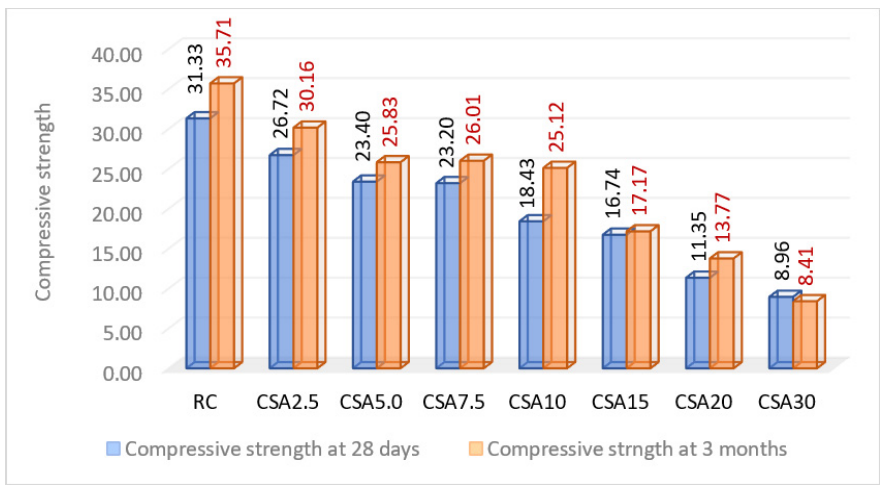
Figure 10. Compressive strength variation at the 28 days and three months of age (N/mm 2 ).